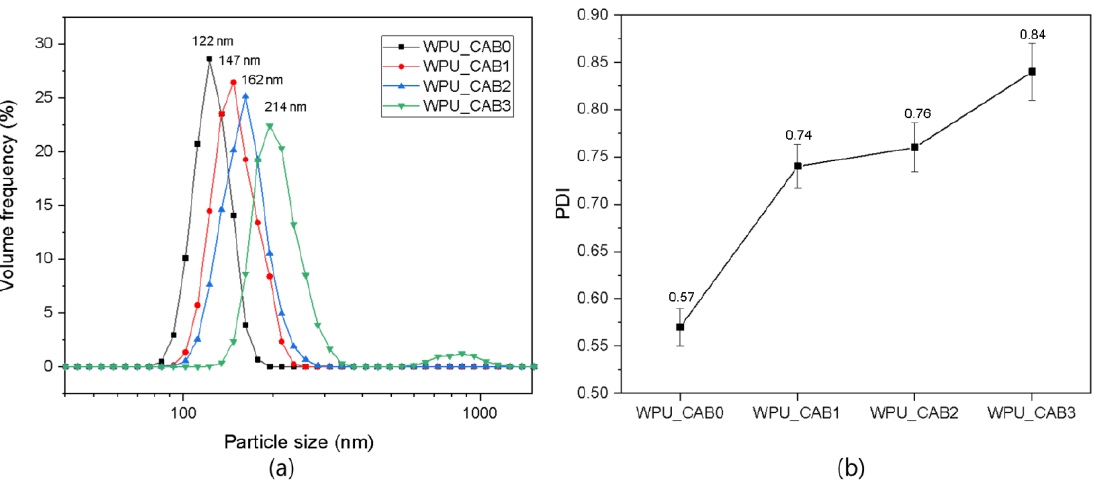
Figure 3. ( a ) Particle size distribution and ( b ) PDI of WPU dispersions with different CAB con-